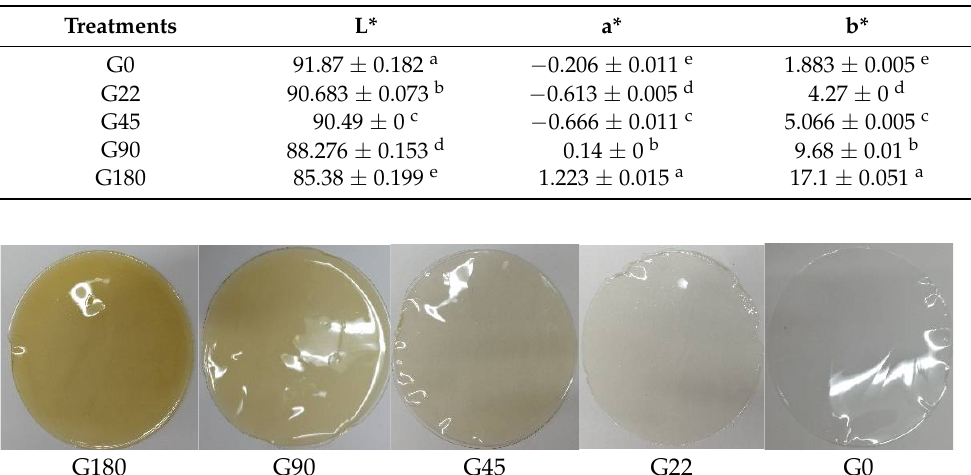
Figure 9. The color difference in the film formulations with respect to the concentration of silver nanoparticles.